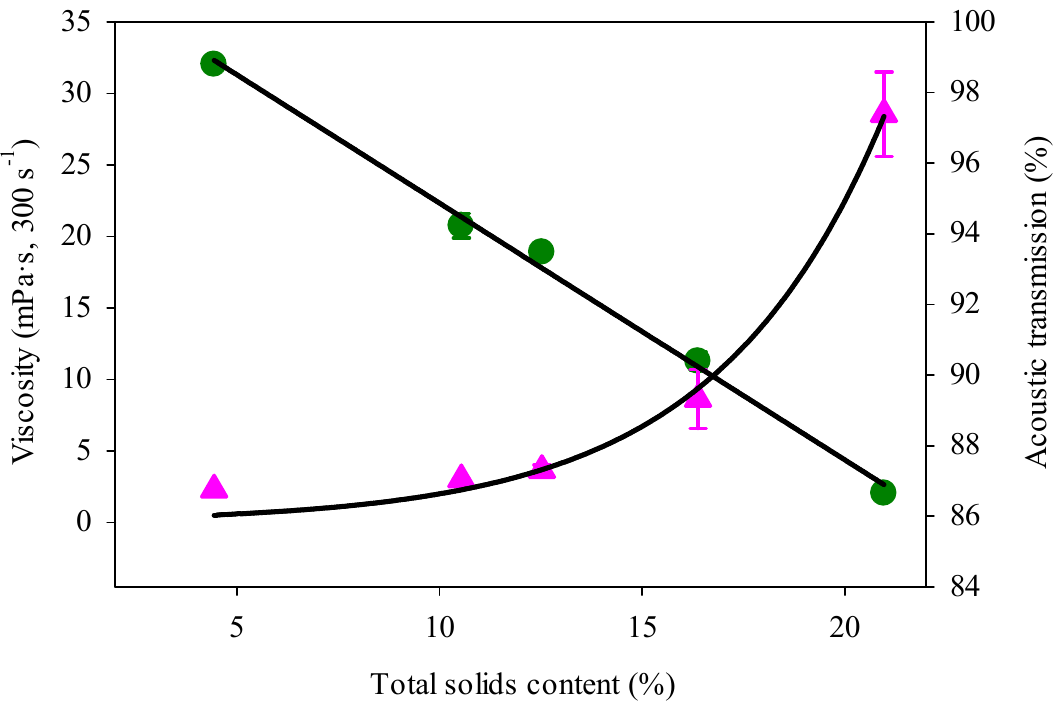
Figure 3. Apparent viscosity ( ▲ ) and acoustic transmission (●) of MPC85 as a function of total solids (TS) content (4–21%) at 45 °C.